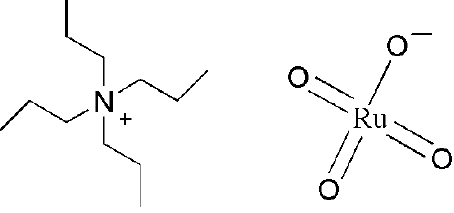
Scheme 1. The molecular formula of tetrapropylammonium perruthenate.